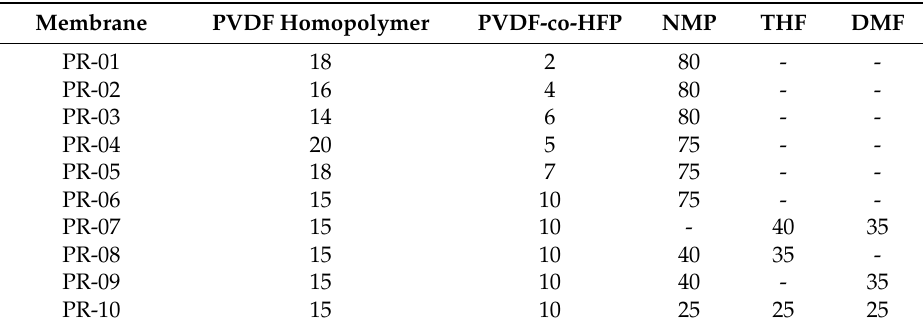
Table 1. Composition of the casting